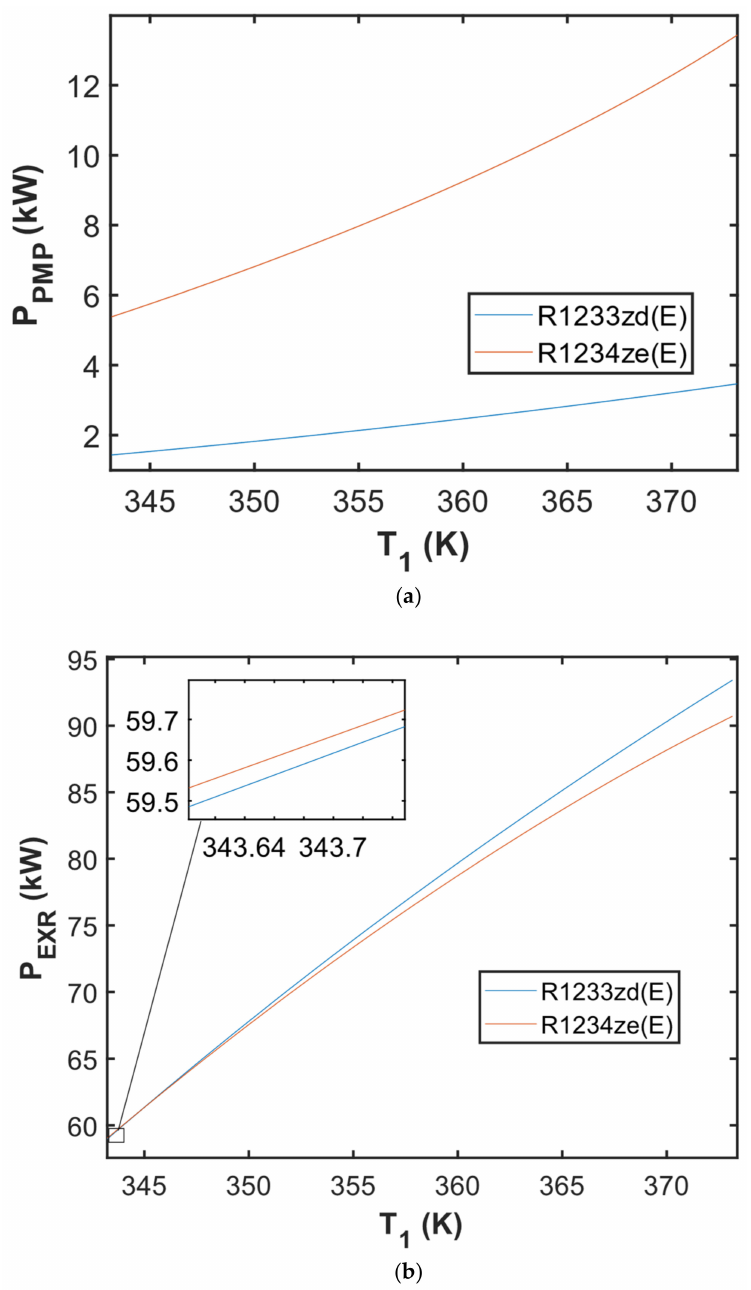
Figure 5. The obtained result of ( a ) power of pump in the P PMP —T 1 diagram; ( b ) power of expander in the P EXR —T 1 diagram simulated with the ∆ T 1 = 1